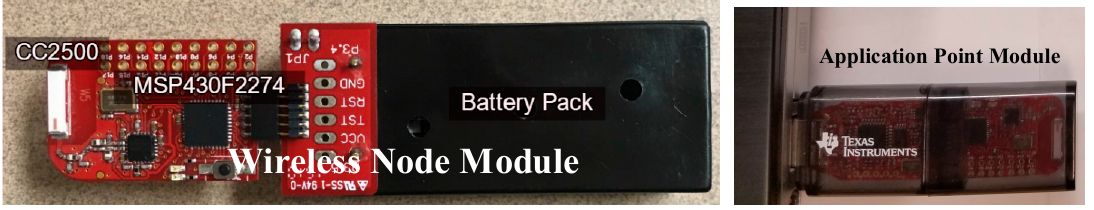
Figure 1. Hardware components of a wireless sensor module and an application point module.